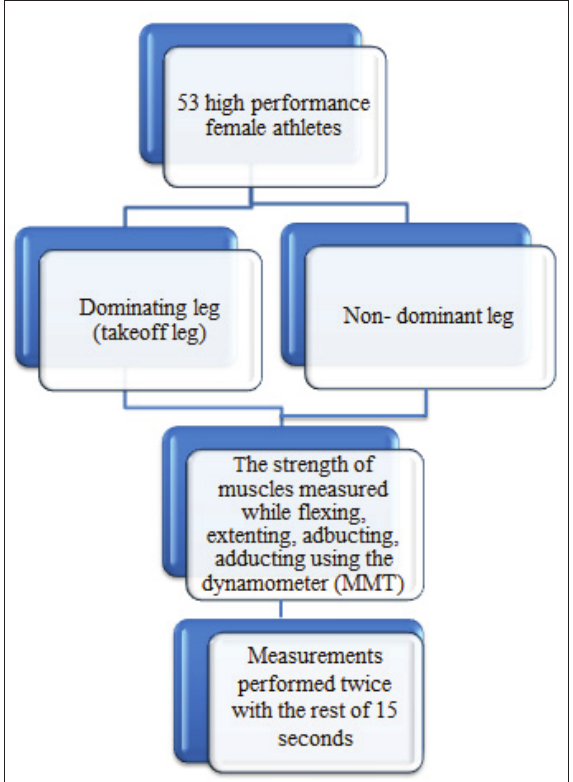
Figure 1. Course of the